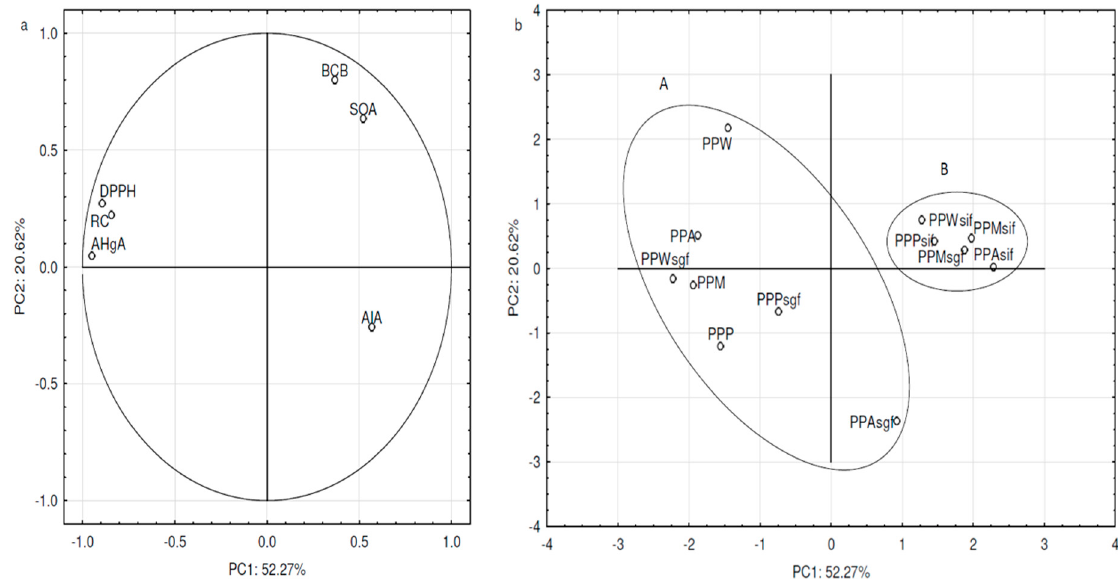
Figure 3. PCA results (( a ) loadings and ( b ) scores plots) based on determined bioactivity values. The HCA analysis confirmed the results obtained with PCA analysis regarding the dominant PC1 axis. The obtained clustering is shown as a dendrogram (Figure 4)